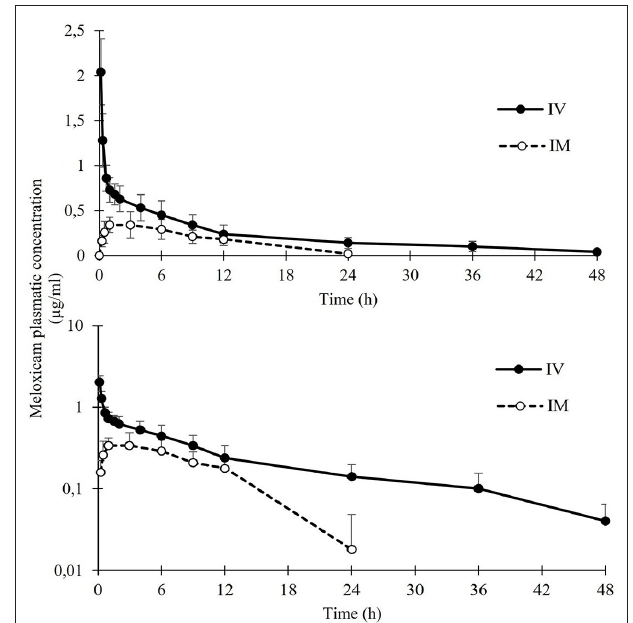
FIGURE 2 | Mean ± SD plasma concentrations of meloxicam in nursehound shark ( Scyliorhinus stellaris ; n = 8) after administration of a single IV (solid circles) or IM dose (open circles) (0.5 mg/kg). Note that data are represented using both linear and logarithmic